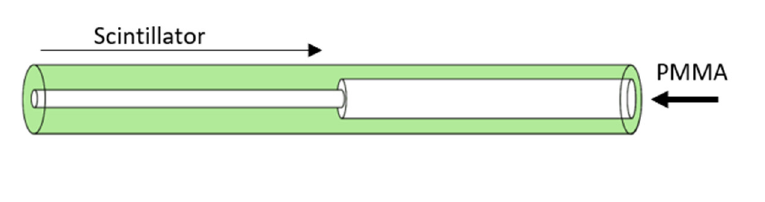
Figure 3. Schematic of the scintillator probe.